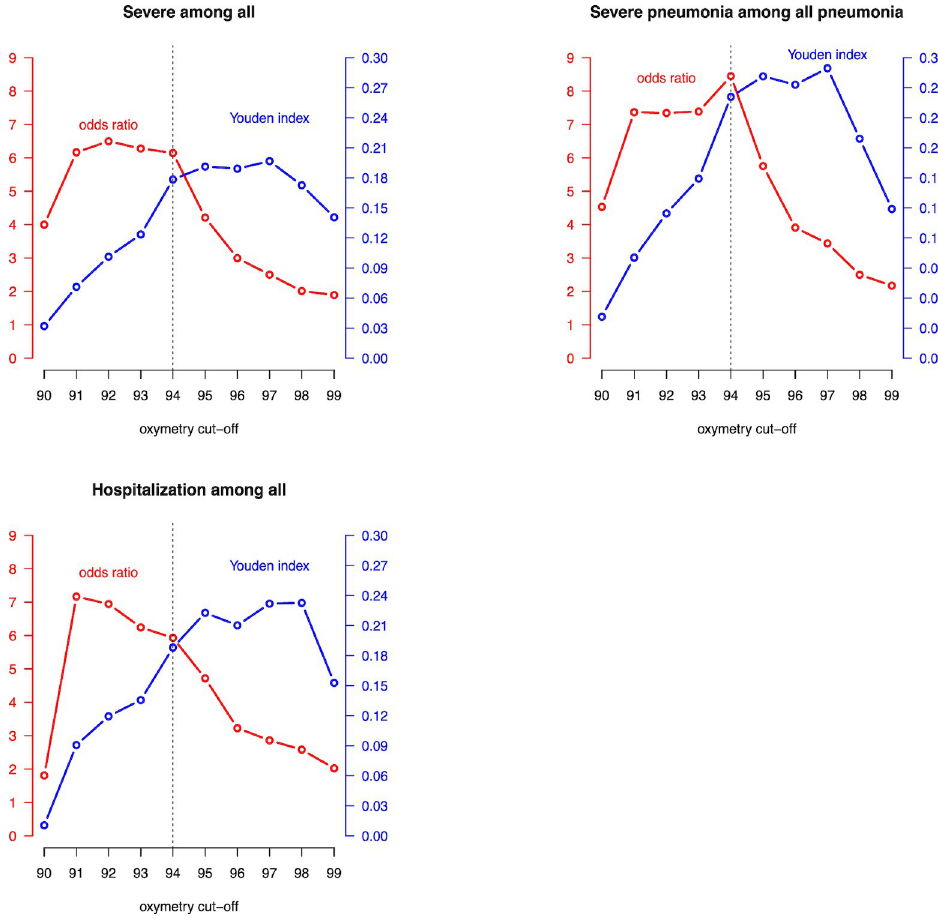
Fig 5. ORs and Youden Indexes for different cut-offs of SpO 2